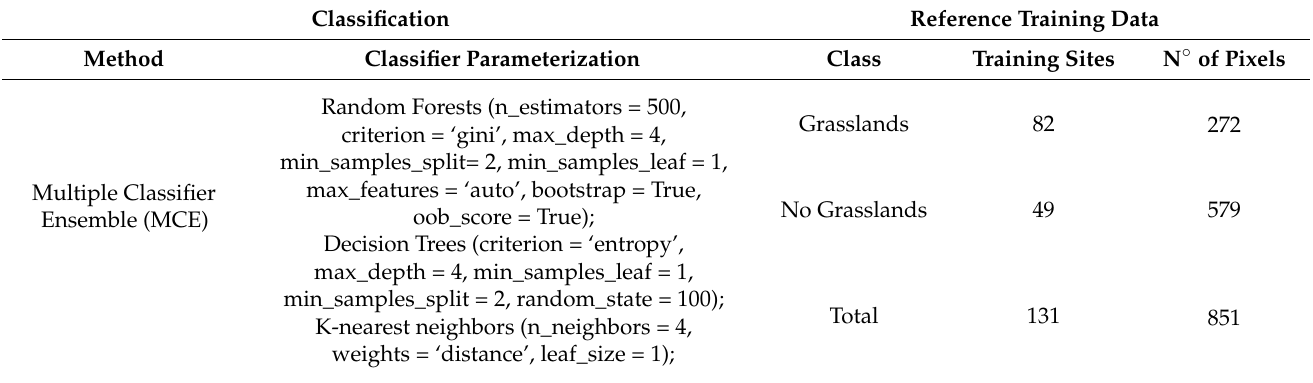
Table 1. Parameterization of the Multiple Classifier Ensemble approach and composition of the reference training